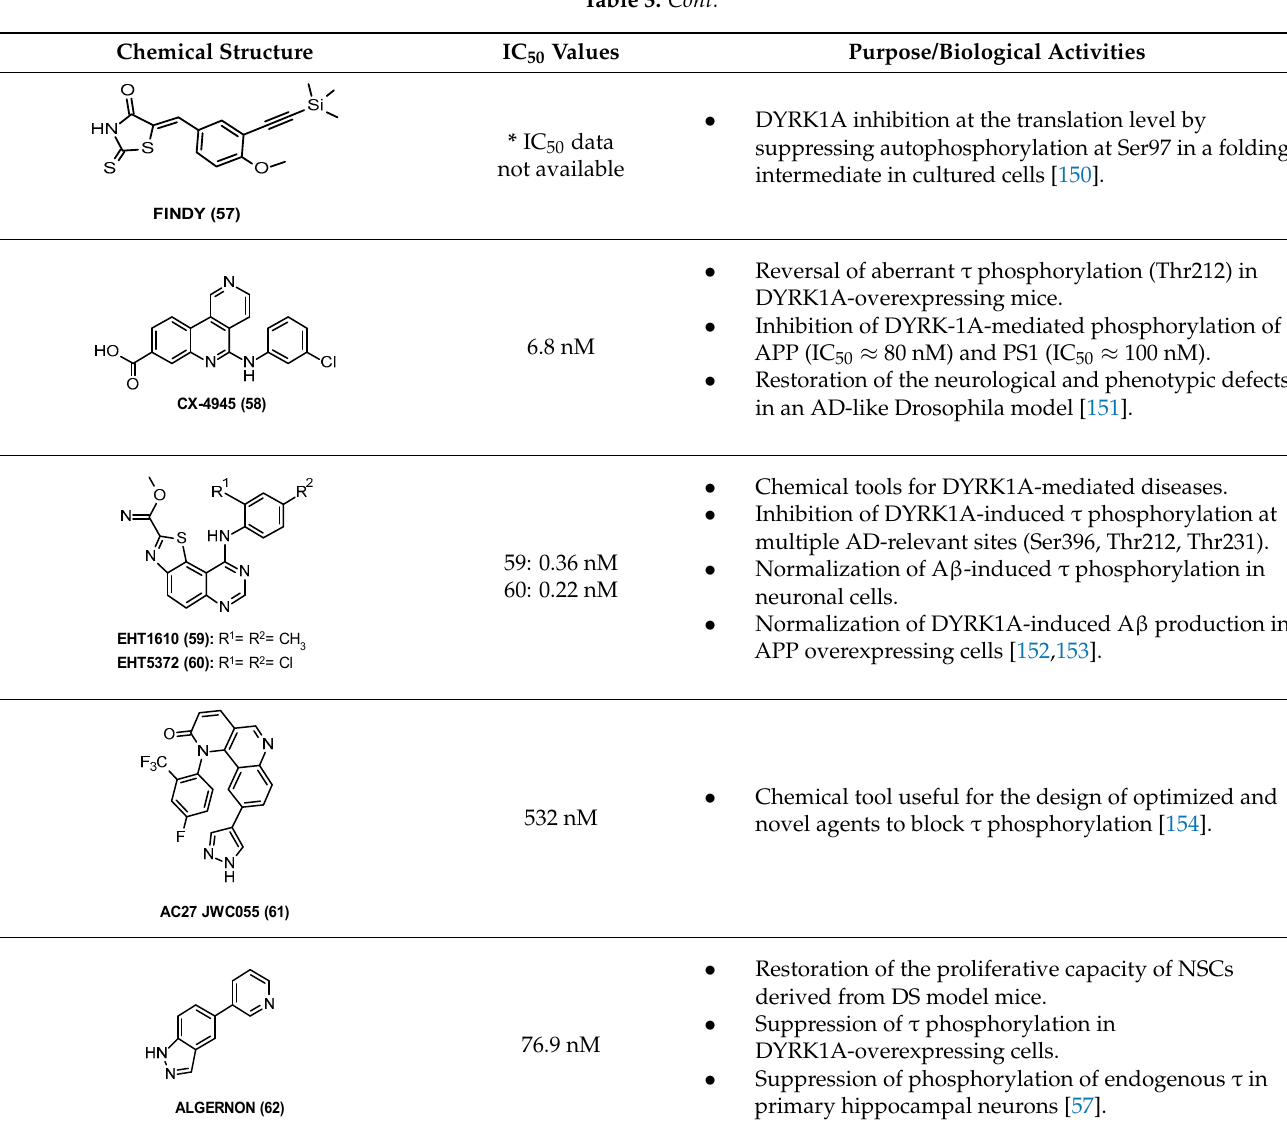
Chemical Structure IC 50 Values